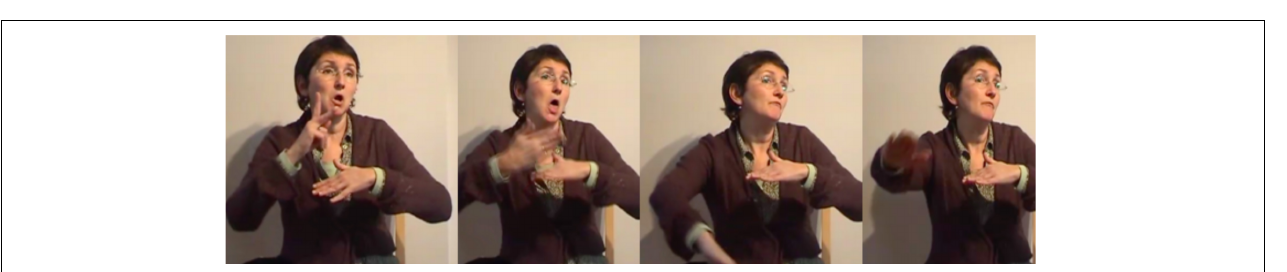
Frontiers in Psychology |